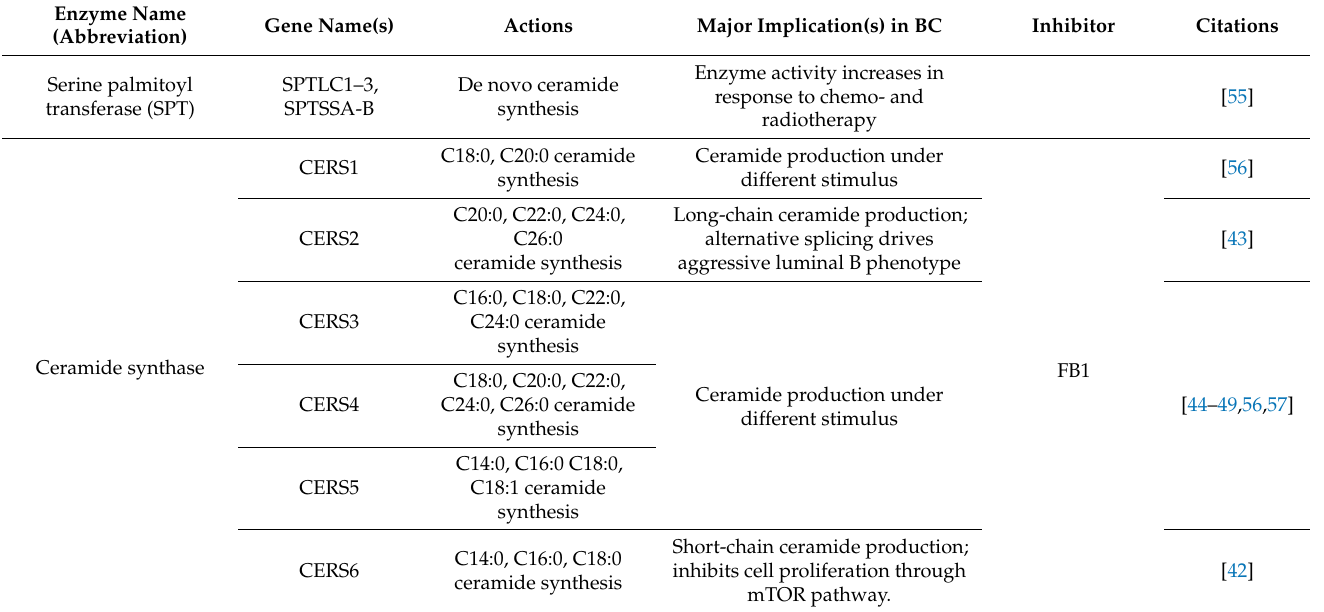
Table 1. List of enzymes and their inhibitors of the ceramide synthesis and turnover